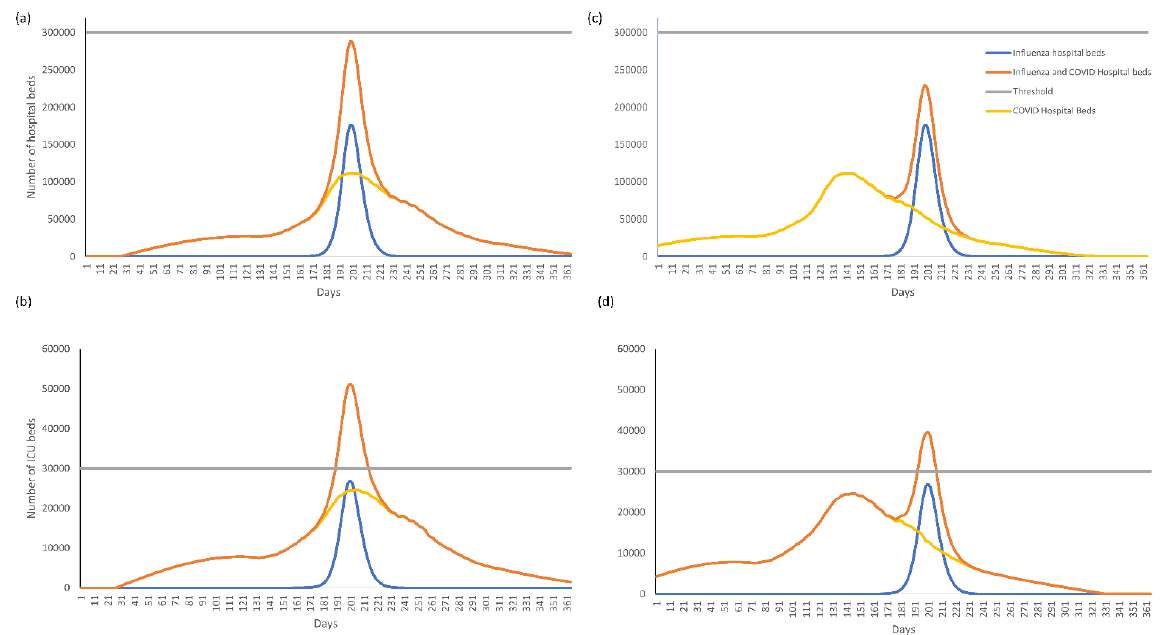
30,000-bed threshold for the duration of the influenza epidemic peak, whereas acute hos- pital beds occupied remained below the 300,000 threshold (Figure 2a,b). If the COVID-19 Figure 1. Excess ( a ) acute and ( b ) ICU beds used for treatment of COVID-19 and influenza patients peak bed occupancy occurred 50 days or more before the influenza peak, total ICU bed by vaccine coverage (base case scenario: QIVe for all age groups) and ( c ) acute and ( d ) ICU beds occupancy was reduced but remained above 30,000 (Figure 2c,d). A vaccination rate of 65% used for treatment of COVID-19 and influenza patients by vaccine coverage (scenario 2: QIVc for 6 was need to reduce ICU bed occupancy below the 30,000 threshold (Figure 3). months to 64 years, aQIV for ≥ 65 years) during high and low incidence influenza seasons.